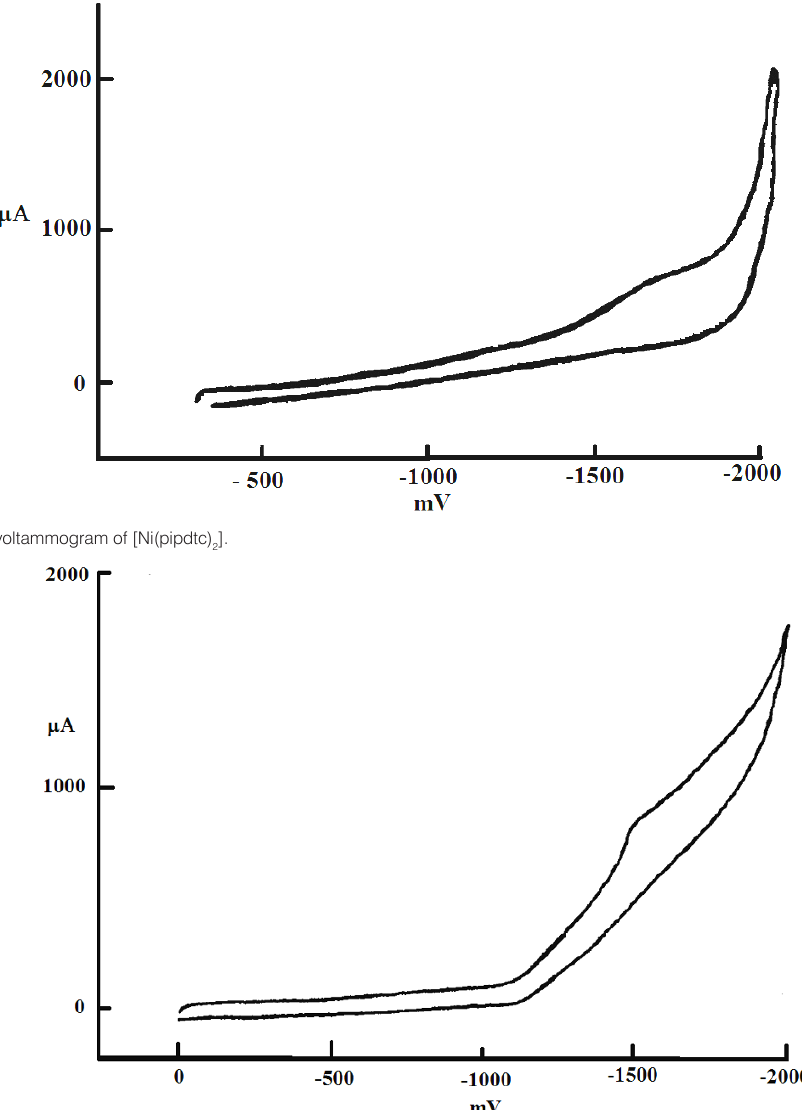
Figure 2. Cyclic voltammogram of [Ni(pipdtc)(PPh